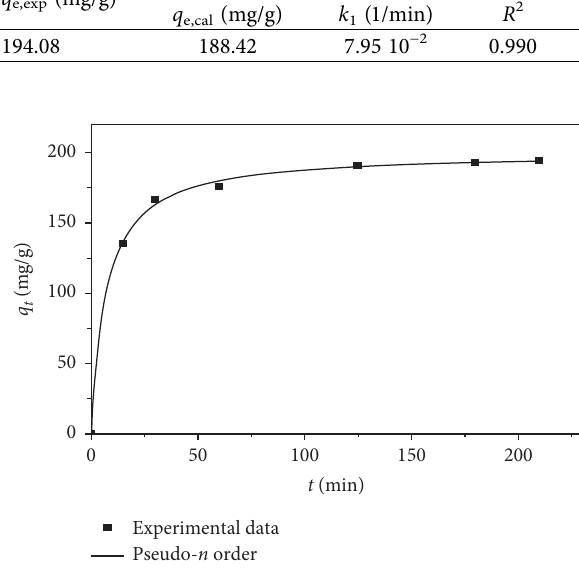
Figure 3: Nonlinear fit of pseudo- n -order kinetic model for MO adsorption onto activated carbon ( C 0 � 100mg/L; adsorbent dose � 0.2g/L; pH ∼ 7; T � 20 ° C).